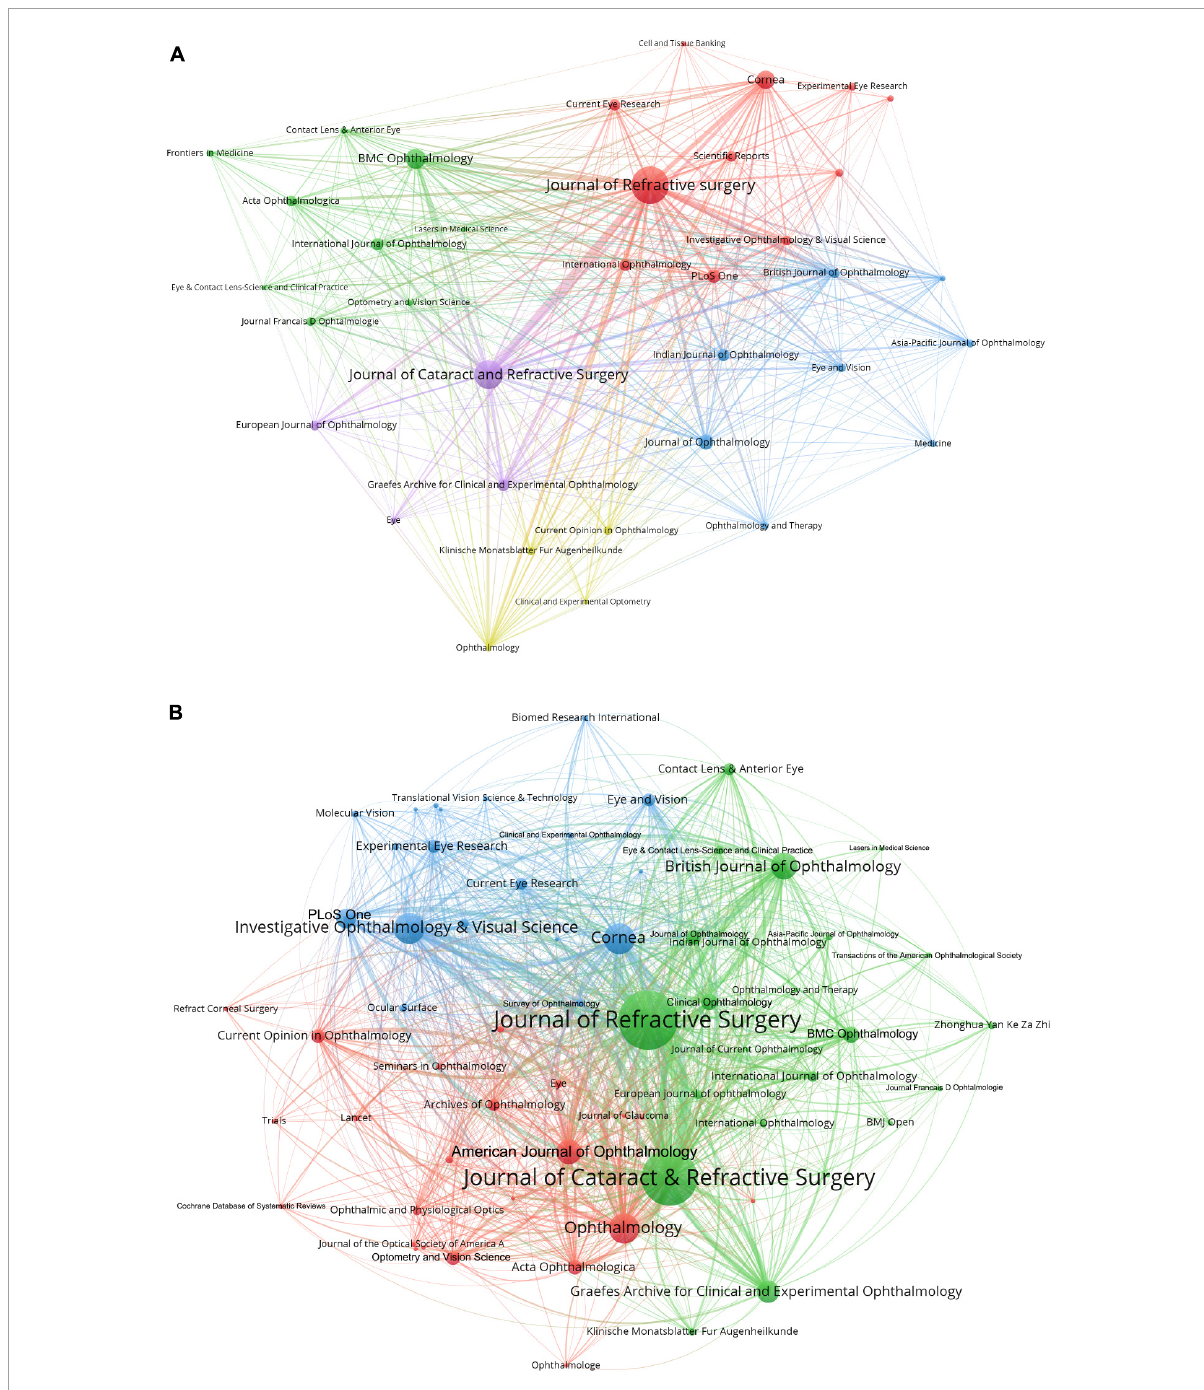
FIGURE4 The network map of scholarly journals (A) and co-cited scholarly journals (B) for SMILE research.